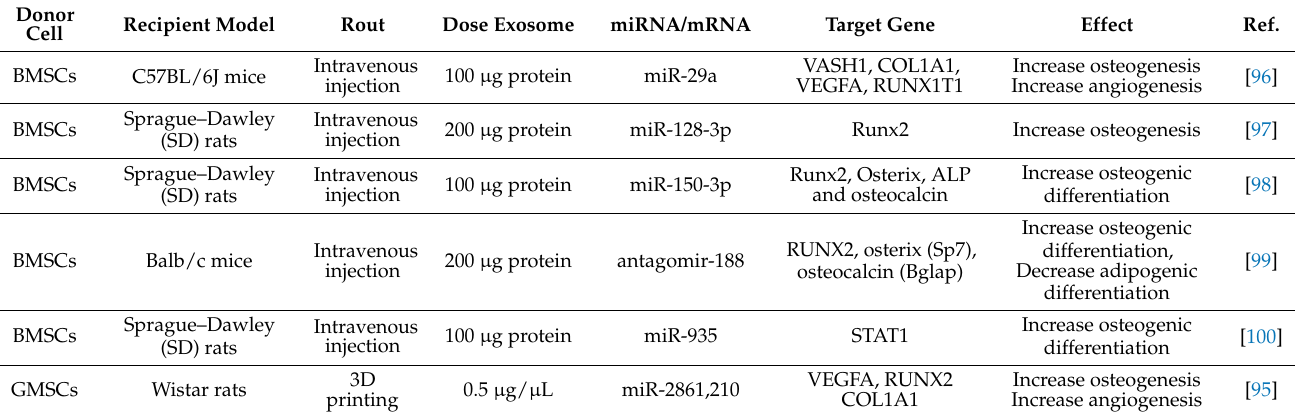
Figure 3. Targeting miRNAs/simvastatin in mesenchymal stem cells using exosomes to enhance osteogenesis. Table 3. Summary of recent studies on loading osteogenic miRNAs into exosomes in